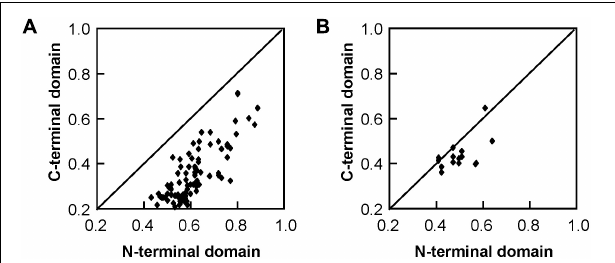
FIGURE 3 | Pairwise protein sequence identity plots for the C-terminal domain versus the N-terminal domain of Salix tau (A) and phi (B) GSTs. Each dot represents the pairwise protein sequence identity for C-terminal domain versus the N-terminal domain between two GST proteins from the same class.